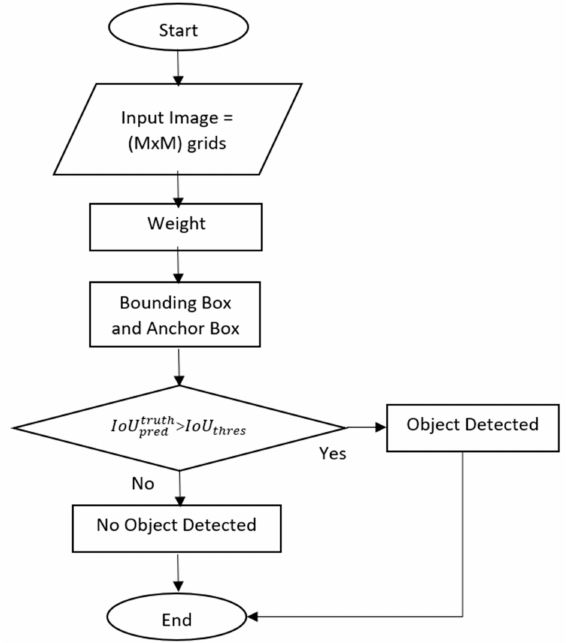
Figure 3. Flow diagram of hand detection.